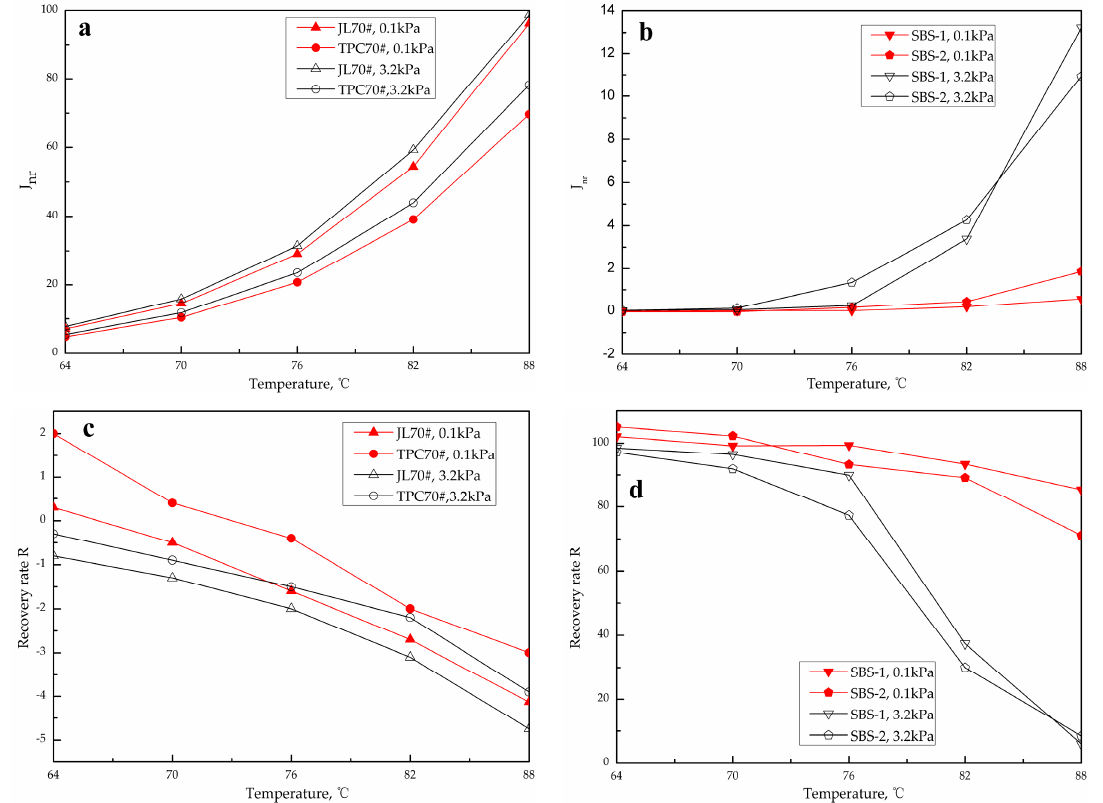
Figure 6. The J nr of matrix asphalts ( a ) and modified asphalts ( b ), and the R of matrix asphalts ( c ) modified asphalts ( d ) under different temperatures and stress conditions.